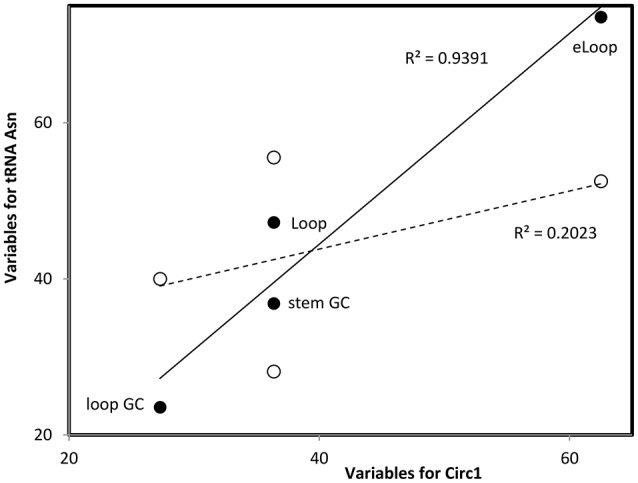
Multivariate comparisons between estimates of secondary structure variables for theoretical sequence Circ1 (from Table 1, x-axis) with corresponding variables for the cloverleaf (filled symbols, continous line) and OL-like (empty symbols, interrupted line) structures formed by the human mitochondrial tRNA Asn. Pearson correlation coefficients r = 0.969, P = 0.0; and r = 0.450, P < 0.05, respectively (values in the figure indicate the square of r). Such comparisons are calculated for each pair of secondary structures that are compared, RNAs are classified into secondary structure clusters (Figure 1) according to highest r.